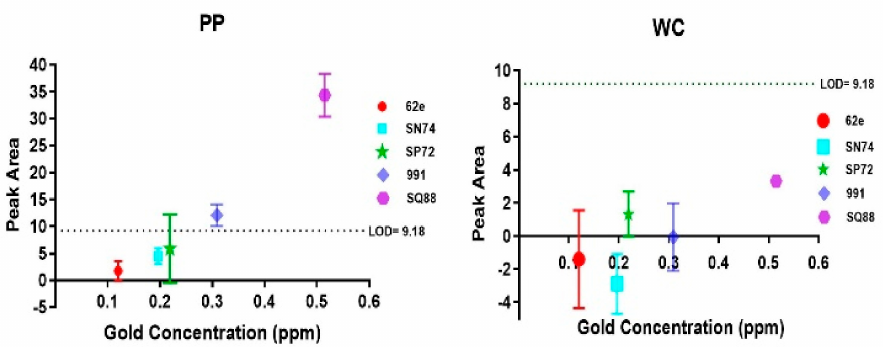
Figure 5. LIBS gold peak area for rock leachates incubated on PP and WC